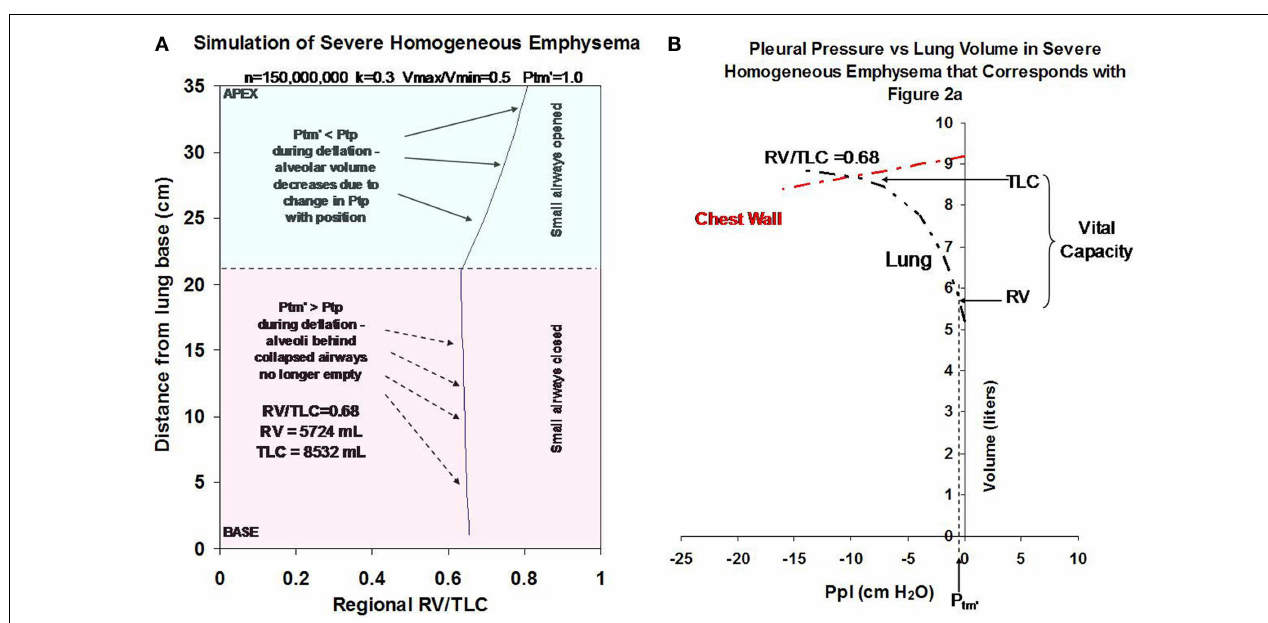
how these changes affect gas trapping and recoil pressure for the overall lung. All simulations were performed assuming a 50% reduction in alveolar number from baseline (i.e., decrease from 300,000,000 to 150,000,000) and assume normal chest wall function (illustrated by red dashed line).